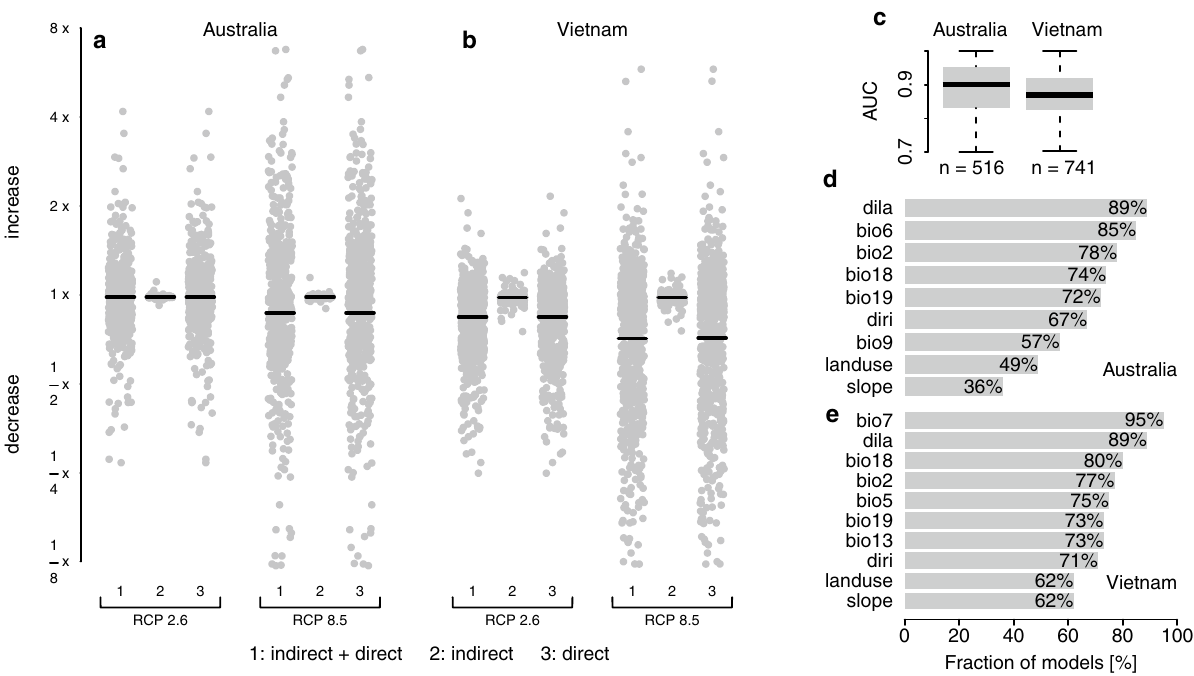
Figure 2. Predicted changes in species’ ecologically suitable ranges. ( a , b ) Illustration of multiplicative changes in species’ ecologically suitable ranges between present (2018) and 2070 for Australia and Vietnam respectively, under three treatments (1) “indirect + direct” (combined biophysical and socio-economic impacts of climate change), (2) “indirect” (net socio-economic impacts) and (3) “direct” (net biophysical impacts). Each point corresponds to a species, black bars are means of ecologically suitable range changes across all species. ( c ) A summary of cross-validated test Area Under the Receiver Operating Characteristics Curve values (AUCs) 25 of models in the two regions as well as the respective number of models ( n ) retained (AUC > 0.7) 26 . AUC provides a measure of a model’s discriminatory performance in terms of how well test predictions discriminate between occupied and unoccupied locations 25,26 . ( d , e ) Fractions of models in which a predictor was used. Full names and definitions of all predictors can be found in Supplementary Table 1. Figure created in R version 3.5.1 27 (https :// www.R-proje